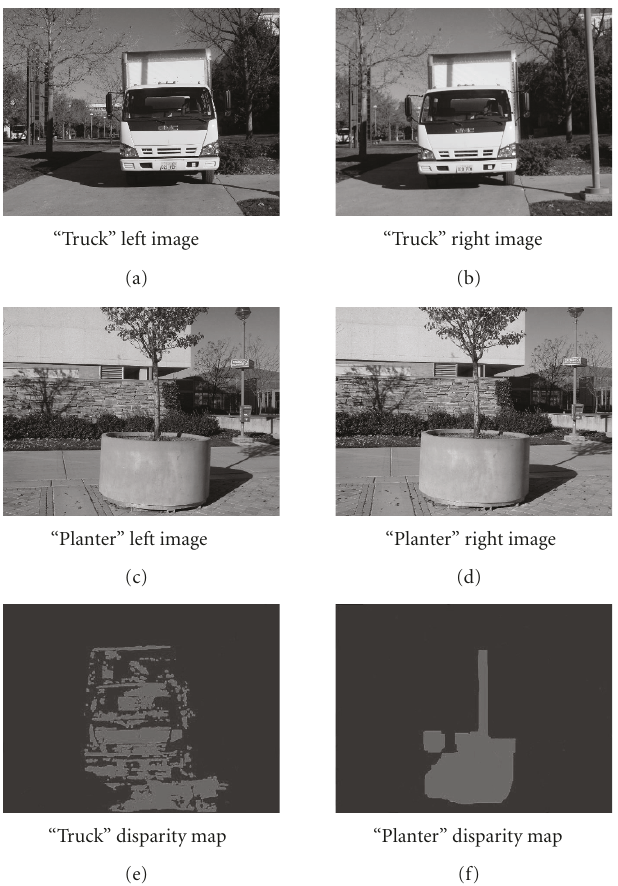
Figure 10: Outdoor scenes: “truck” and